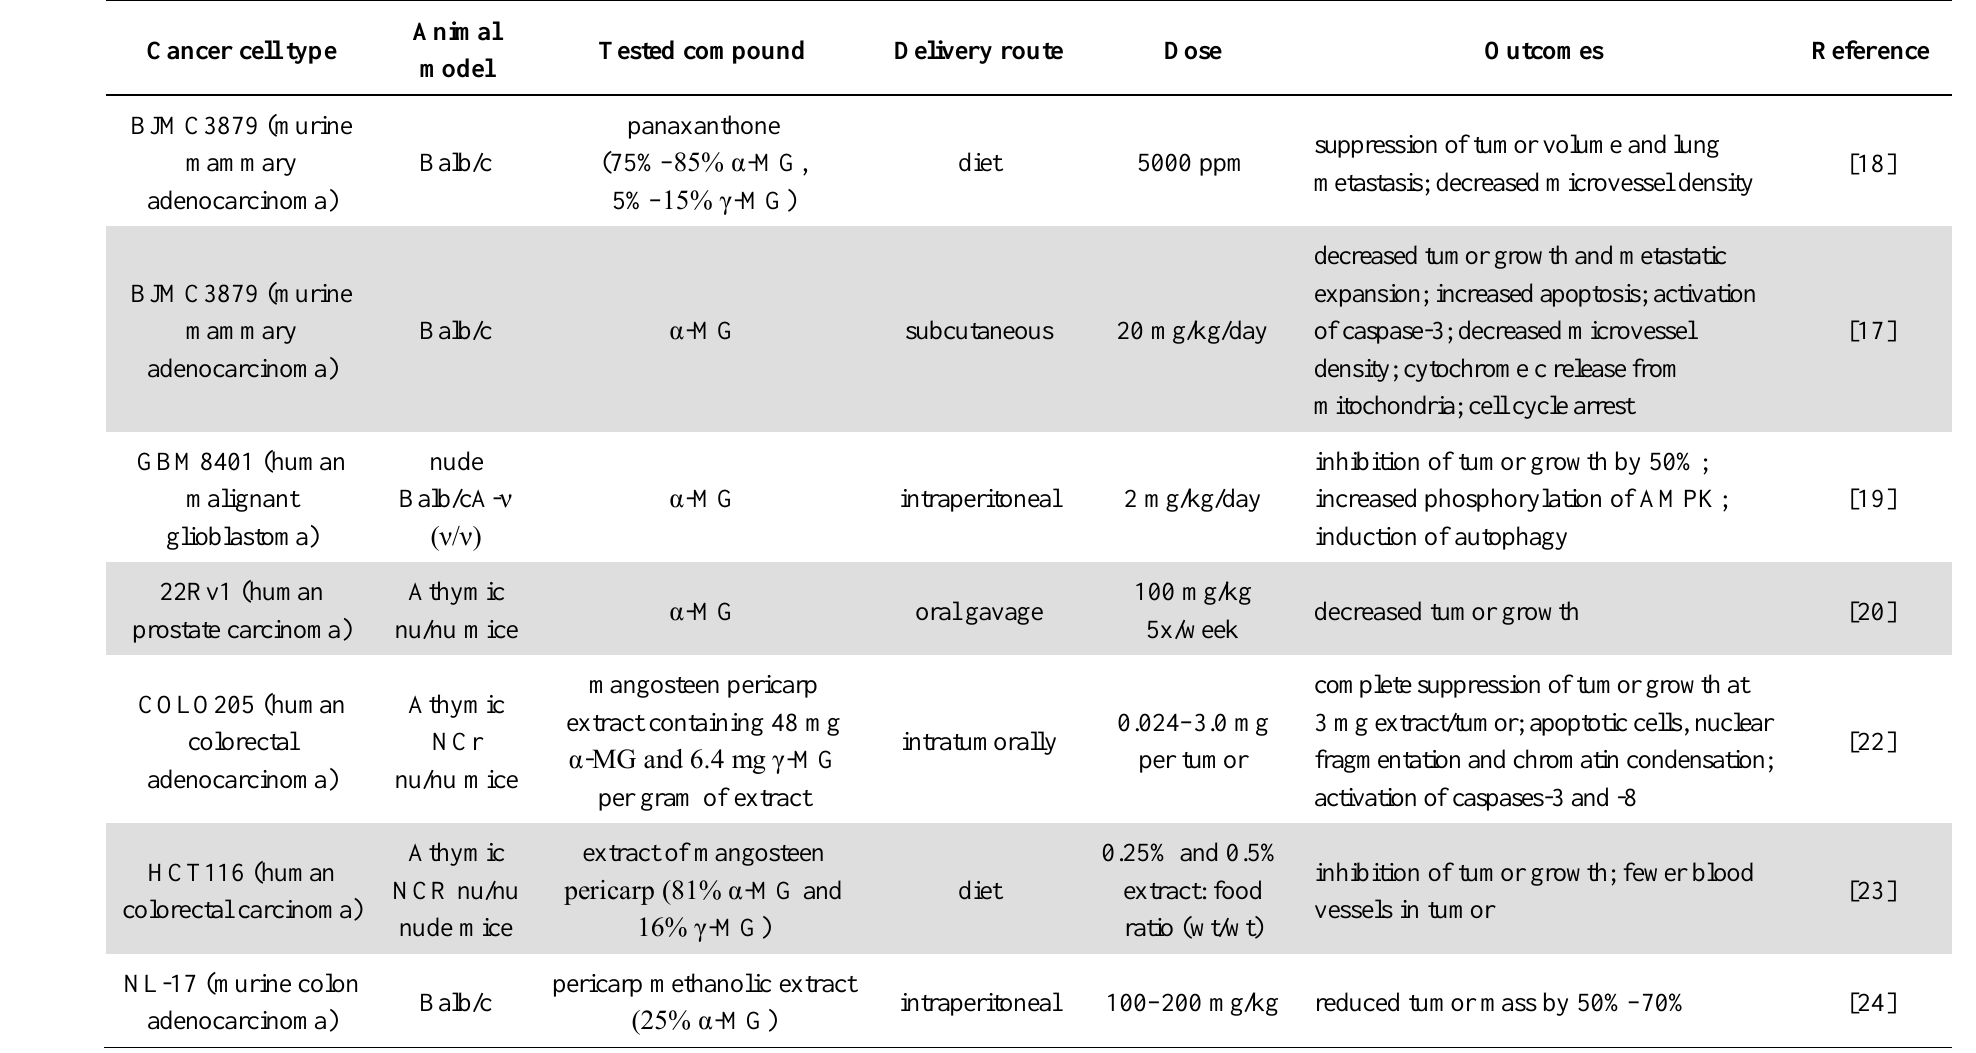
Table 2. In vivo anti-tumorigenic activities of mangosteen